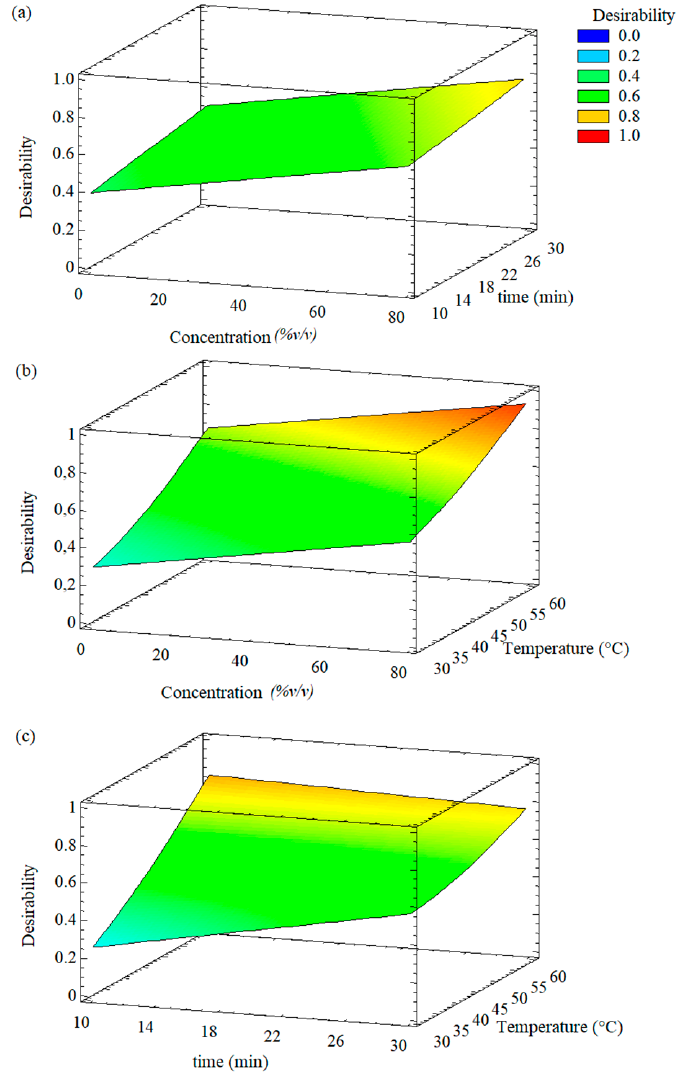
Figure 6. Response surface plots for simultaneous optimization of the total polyphenols content and DPPH radical scavenging activity of the extracts from Welsh onion leaves. ( a ) ethanol concentration and time; ( b ) ethanol concentration and extraction temperature; ( c ) time and extraction temperature.